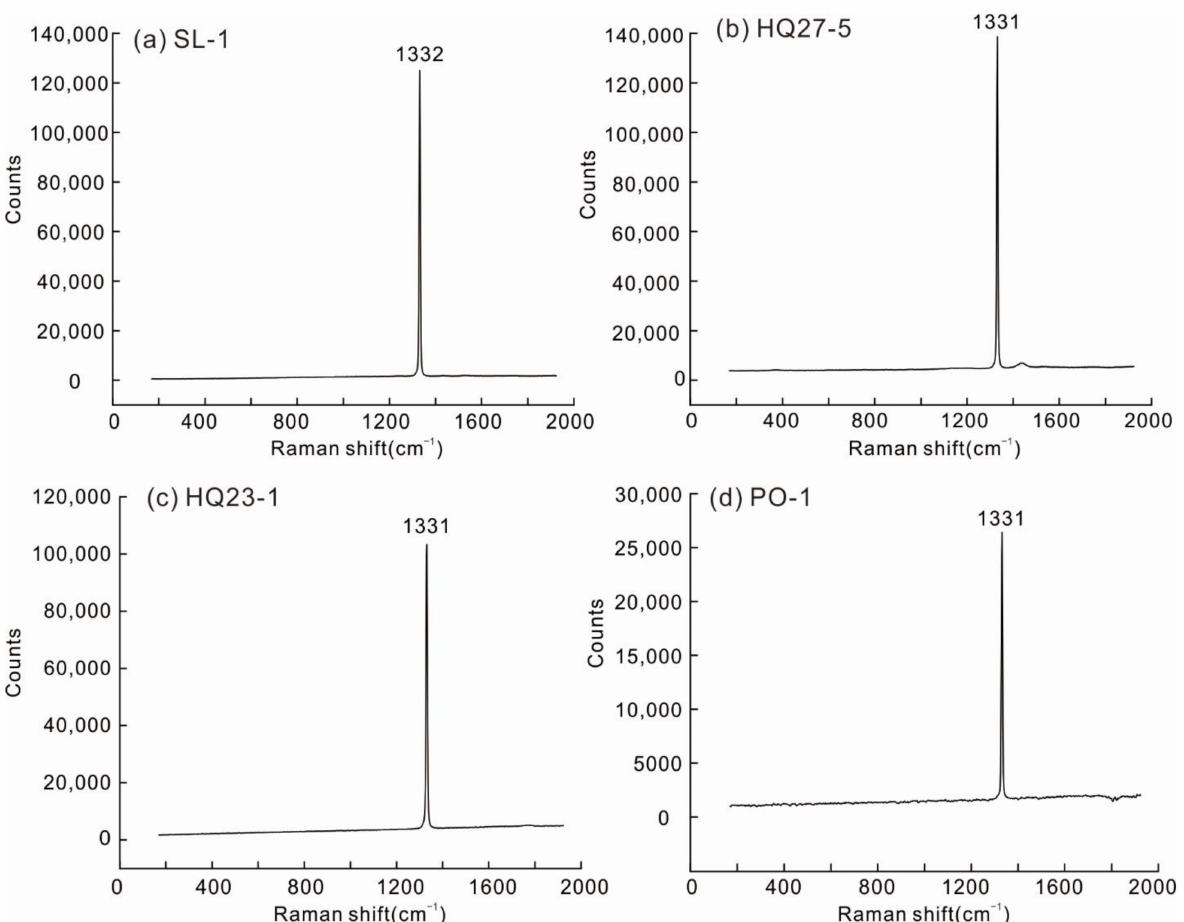
Figure 5. Raman strata of representative diamond samples in three kimberlite belts. ( a ) Sample SL-1 and ( b ) sample HQ27-5 in the Changmazhuang belt; ( c ) Sample HQ23-1 in the Xiyu belt; ( d ) Sample PO-1 in the Poli